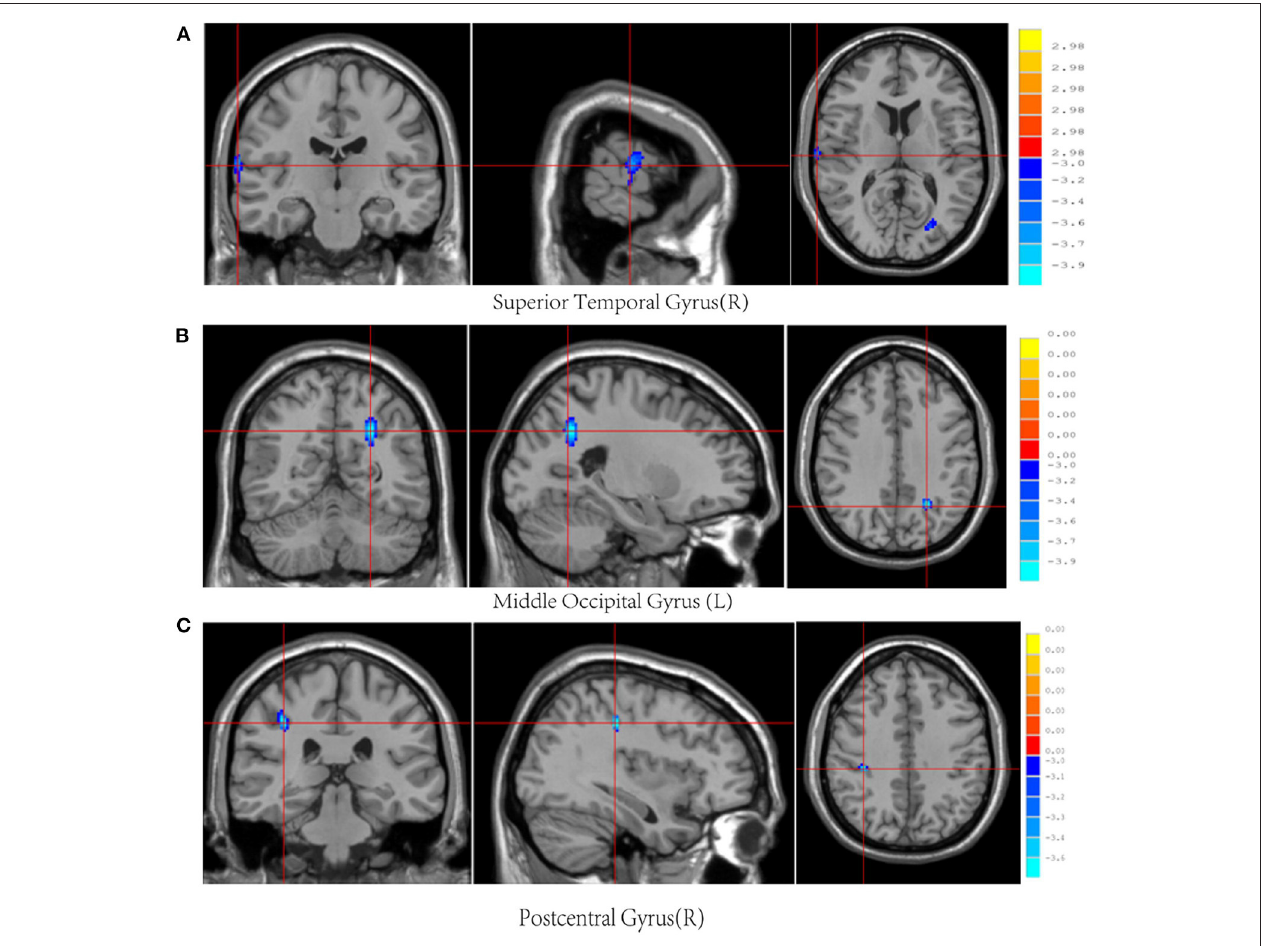
FIGURE 1 | Results of brain region changes in mTBI female patients compared with female controls. The CBF of female patients in right superior temporal gyrus (A) , left middle occipital gyrus (B) , and right postcentral gyrus (C) showed decreased perfusion levels compared with female controls. mTBI, mild traumatic brain injury; CBF, cerebral blood